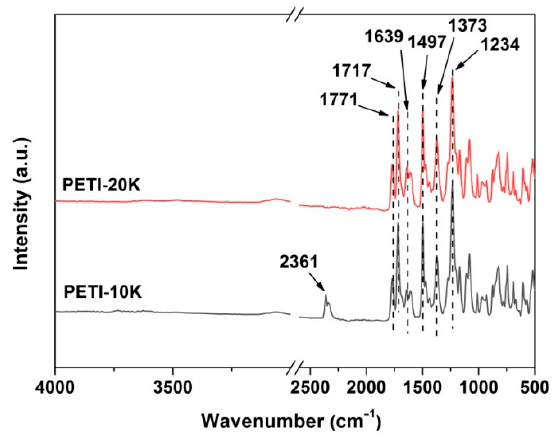
Figure 6. ATR ‐ FTIR spectra of the electrospun PI nano ‐ fibrous membranes. Figure 6. ATR-FTIR spectra of the electrospun PI nano-fibrous